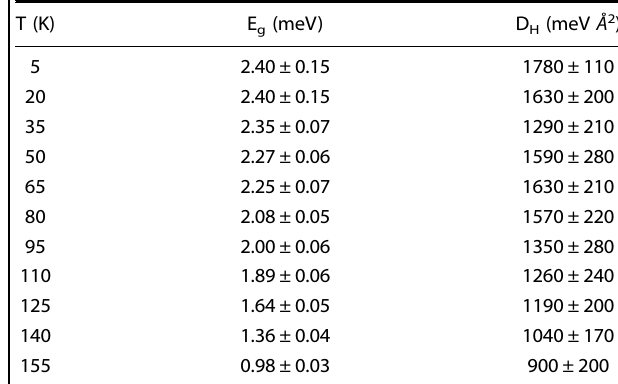
Table 2. Experimental gap energies determined by ex-gaussian fi ttings for 35 ≤ T ≤ 155